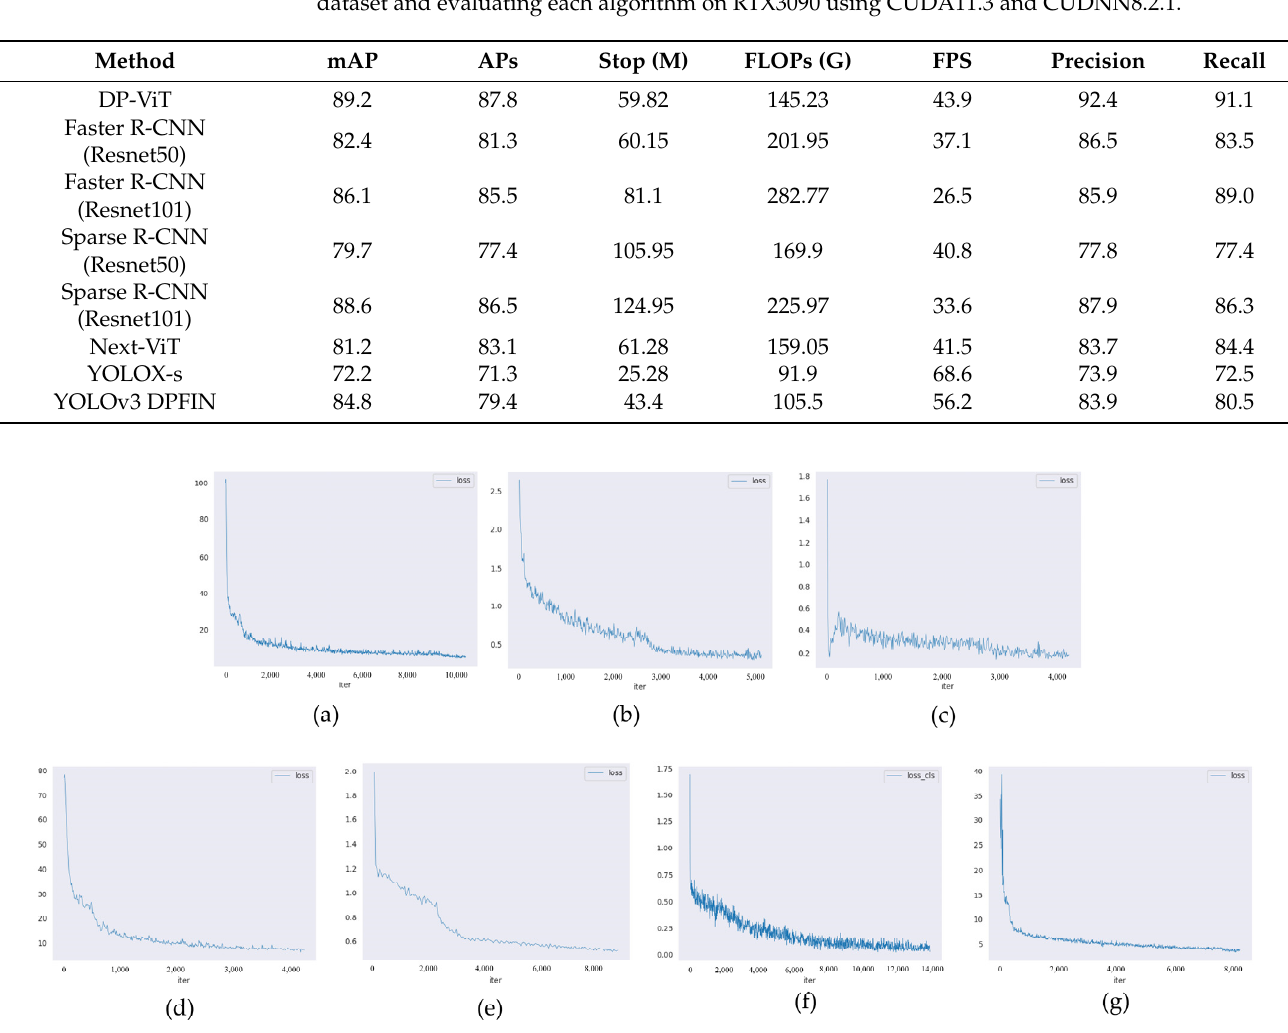
Table 2. Detection Build on Forward-Look Sonar, training and testing on the forward-look sonar dataset and evaluating each algorithm on RTX3090 using CUDA11.3 and CUDNN8.2.1.